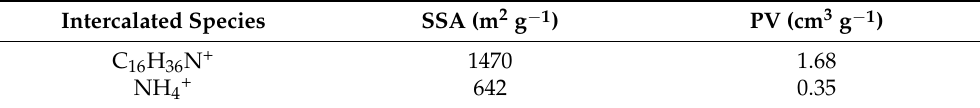
Table 3. Specific surface area (SSA) and pore volume (PV) accessible to N 2 molecules calculated by molecular simulations for the layered vanadium oxide structures in which the distance of the empty interlayer space has been imposed equal to the experimental value as a function of the intercalated